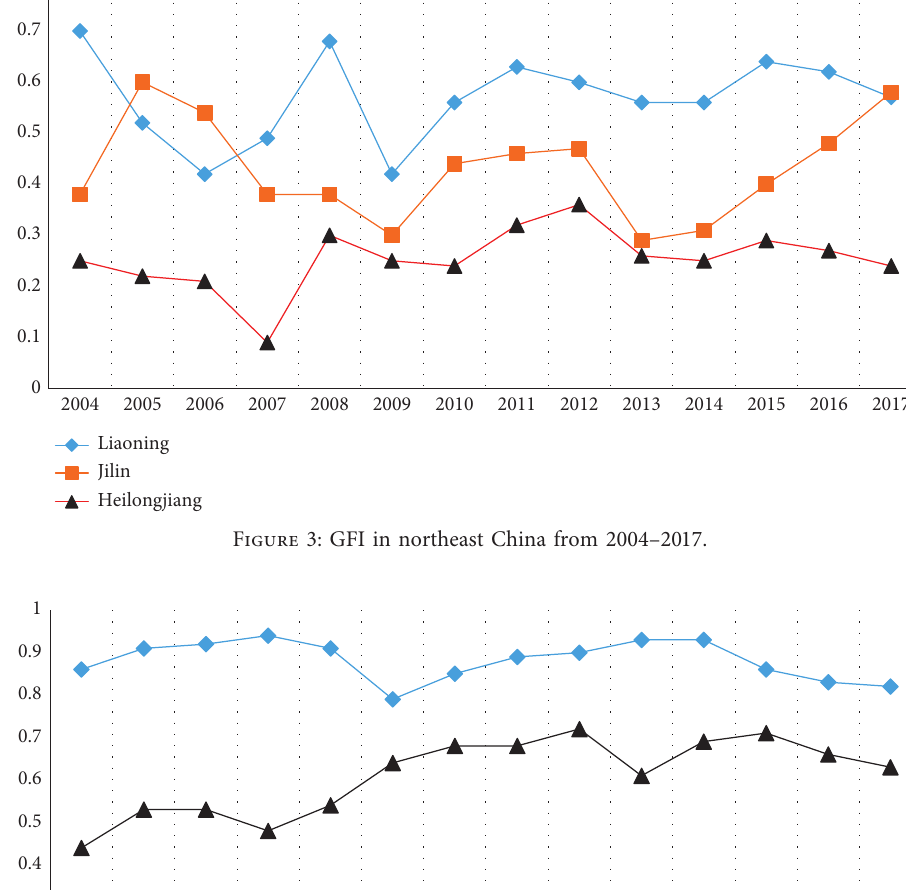
Figure 4: GFI in east China from